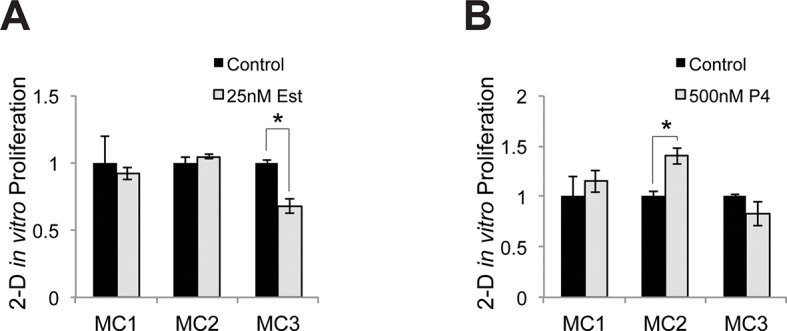
Relative proliferative response to estrogen and progesterone treatment.(A) Identical numbers of melanocytes from 3 donors were seeded in parallel and treated with vehicle or estrogen; relative cell number after 5 days was determined. (B) Identical numbers of melanocytes from 3 donors were seeded in parallel and treated with vehicle or progesterone; relative cell number after 5 days was determined. n=3 biologic replicates for each experiment. Error bars denote +/- s.d., *p<0.05.1DOI: